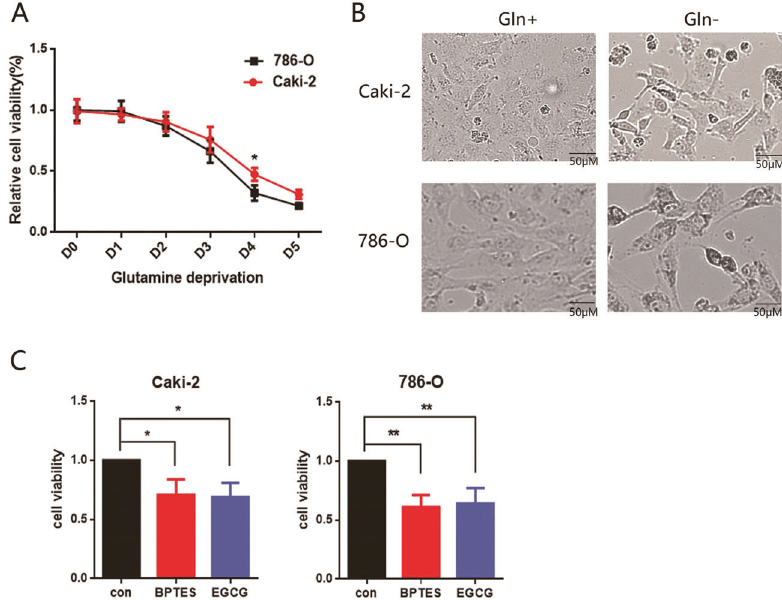
Fig. 1 VHL-de fi cient cells more sensitive to glutamine metabolism. A , B VHL-pro fi cient (Caki-2) and VHL-de fi cient (786-O) cells were cultured in complete medium or medium absence of glutamine. A Cell growth was determined by CCK8 and normalized to the corresponding cell type (Caki-2 or 786-O) grown in complete medium. B Representative phase-contrast photomicrograph was used to monitor cell survival after cultured for 96 h. C Caki-2 and 786-O cells were cultured for 48 h by complete medium with or without BPTES (10 μ M)/EGCG (25 μ M). Cell viability was determined by CCK8 assay. Error bars represent mean ± SD ( n = 3). * P < 0.05, ** P < 0.01. Student ’ s t test compared treated groups with corresponding control